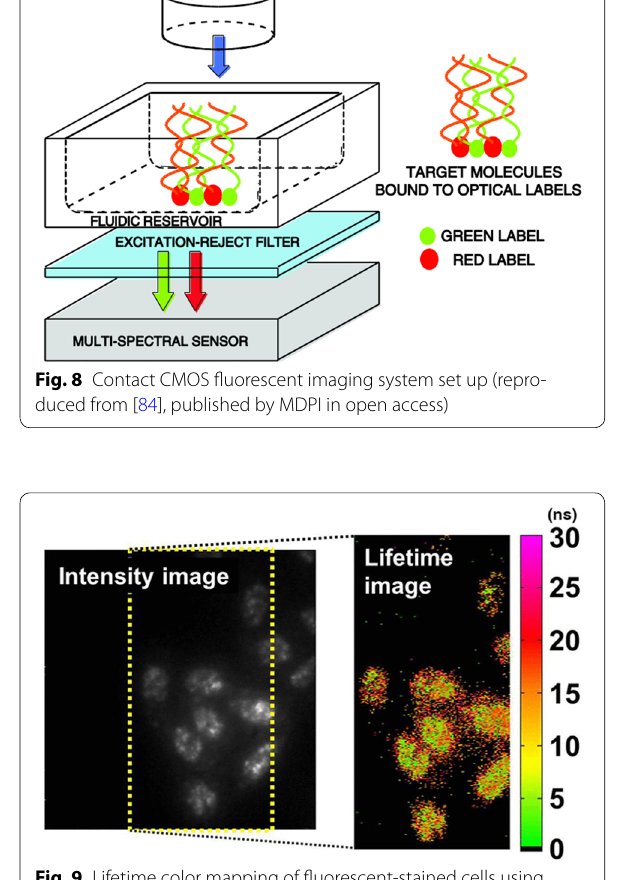
Fig. 9 Lifetime color mapping of fluorescent‑stained cells using contact CMOS sensor (reproduced from [101] with permission, © 2016